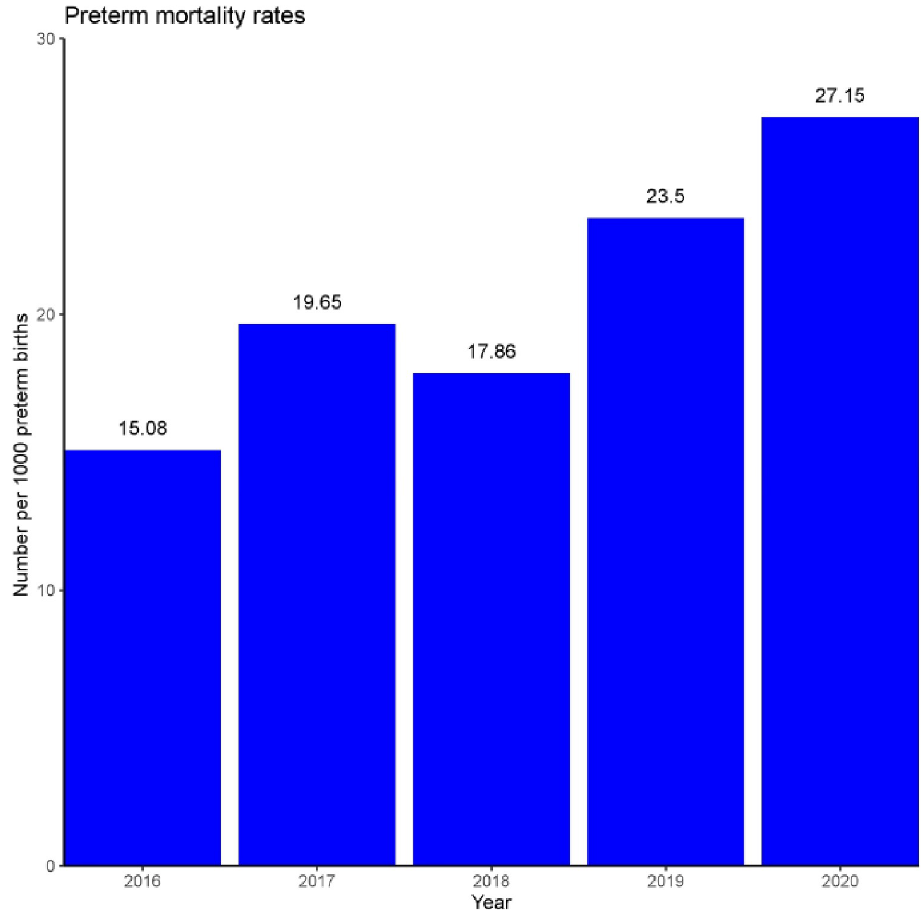
Fig 1. Preterm mortality rates by year. Temporal differences in mortality rates per 1000 preterm births (32–36 weeks gestation) between